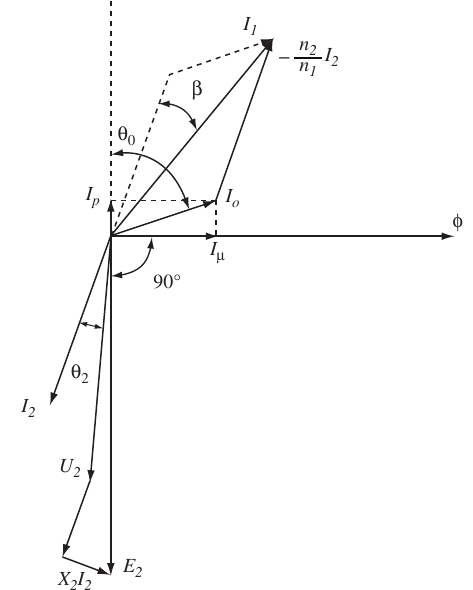
Figure 2. Phasor diagram of a current